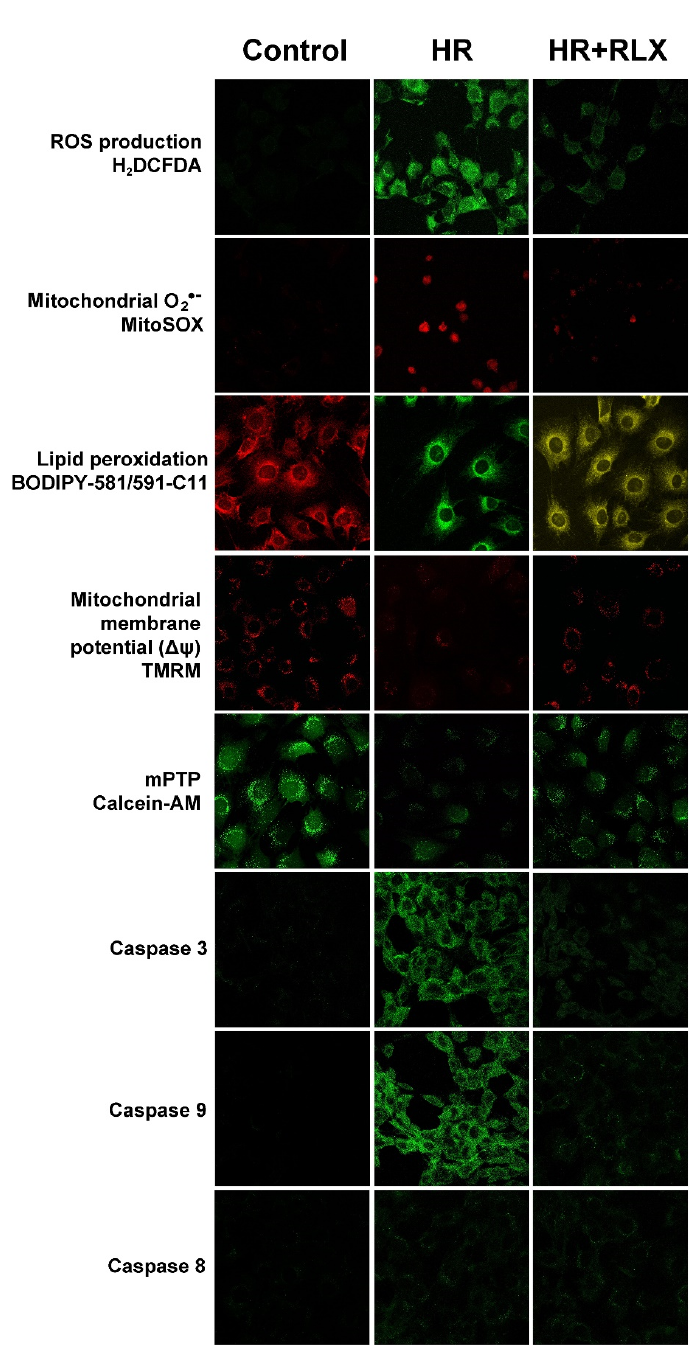
Figure 2. Representative confocal micrographs of H9c2 cells at the noted experimental